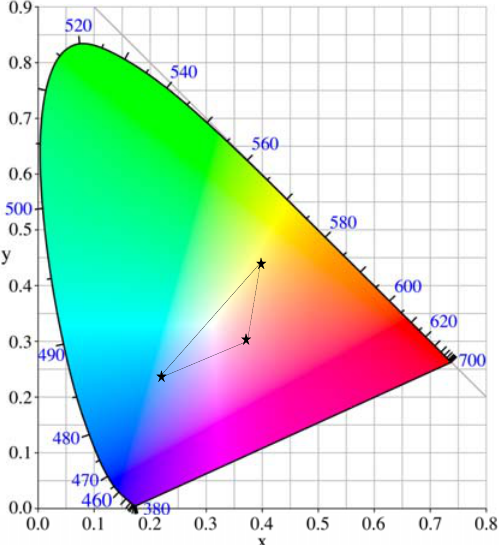
Figure 7. Color image on CIExy 1931.